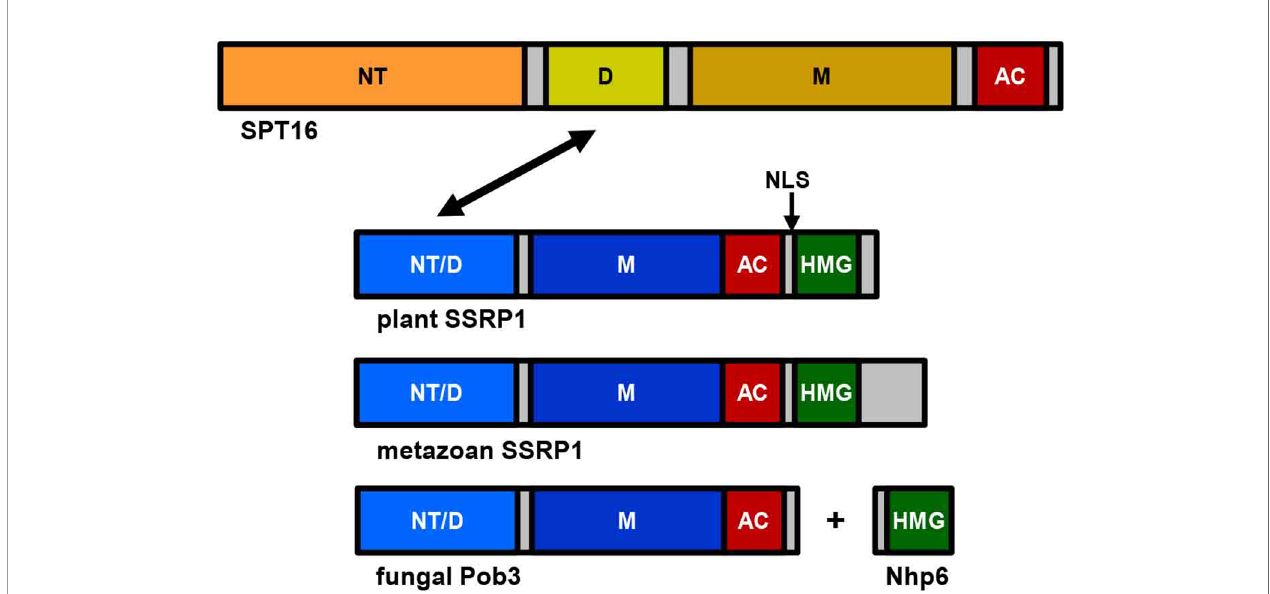
FIGURE 1 | Schematic representation of the FAcilitates Chromatin Transcription (FACT) subunits SPT16 and SSRP1. While the overall structure of SPT16 is essentially conserved throughout eukaryotes, there are differences in the C-terminal region of SSRP1 (Pob3 in fungi). SPT16 consists of N-terminal domain (NT), dimerisation domain (D), middle domain (M), and acidic C-terminal domain (AC), while SSRP1/Pob3 proteins of different eukaryotes are composed of N-terminal domain (that is required for heterodimerisation (NT/D) with SPT16, indicated by an arrow), middle domain (M), acidic region (AC), and HMG-box domain (HMG), which in case of yeast Pob3 is provided by the separate protein(s) Nhp6a/b. Plant SSRP1 contains a nuclear localisation signal (NLS, indicated by an arrow) within a short basic region linking the acidic domain and the HMG-box (Röttgers et al.,